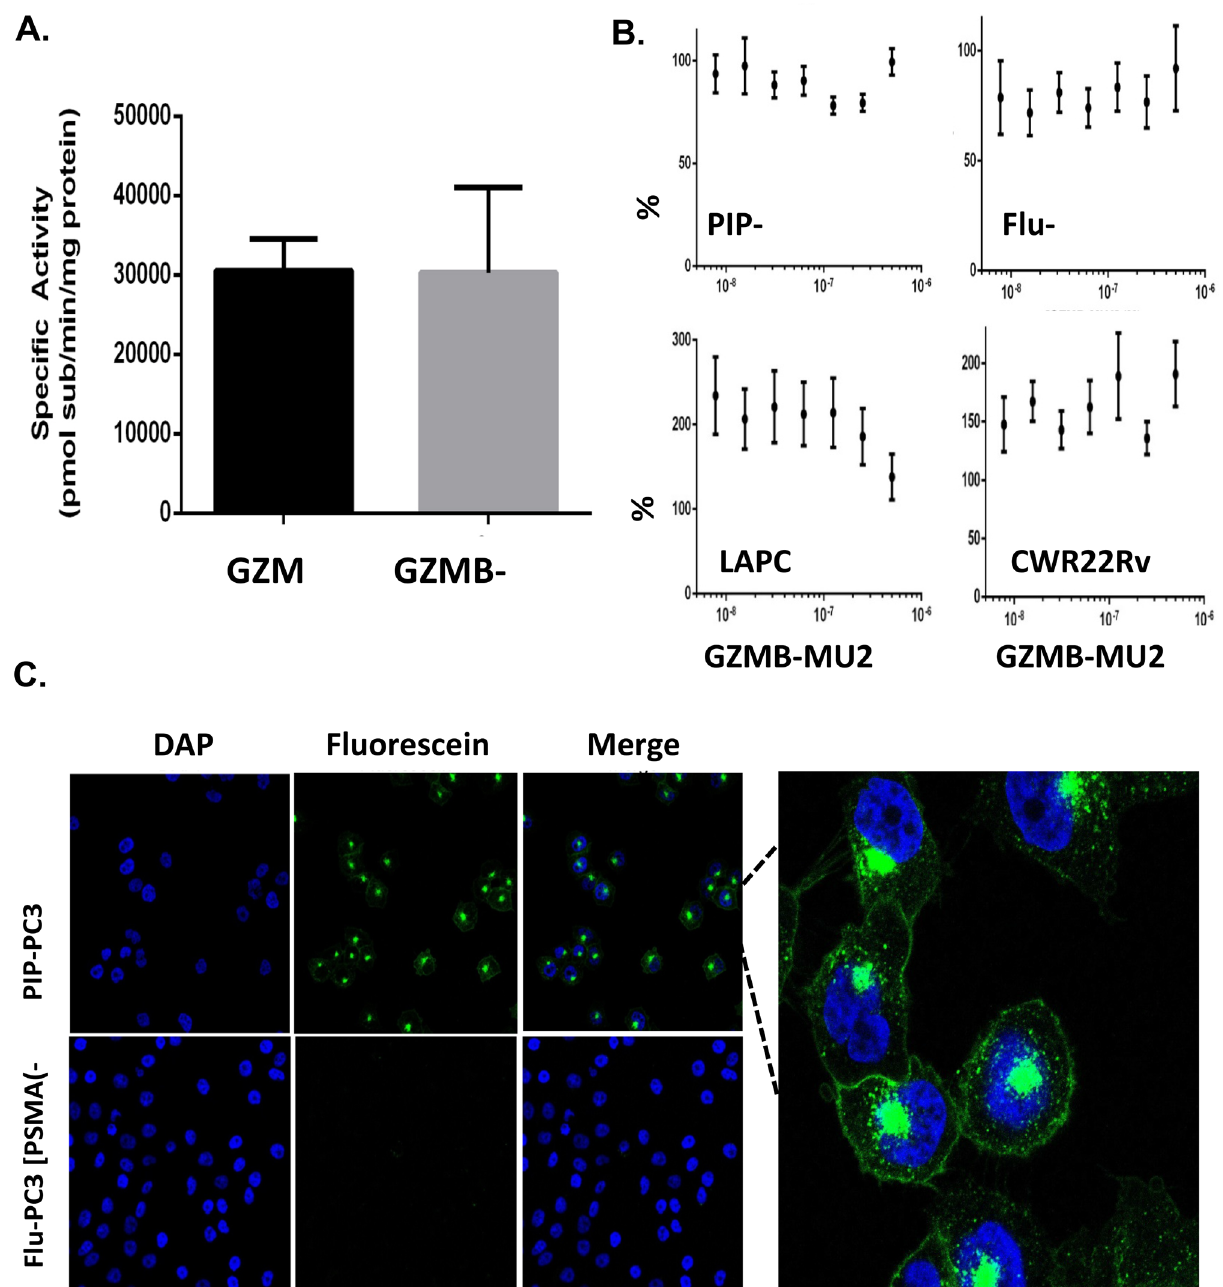
Figure 3. GZMB-MU2 internalizes into PIP cells but does not induce cell death. ( A ) Enzymatic activity of GZMB or GZMB-MU2 using a GZMB-specific fluorescent substrate. ( B ) Cytotoxicity of purified GZMB-MU2 on PIP-PC3, Flu-PC3, LAPC4, or CWR22 Rv1. ( C ) Confocal microscopy of PIP or Flu-PC3 cells treated with Flor-GZMB-MU2 for 1 h at 20 × magnification (left) or 60 ×